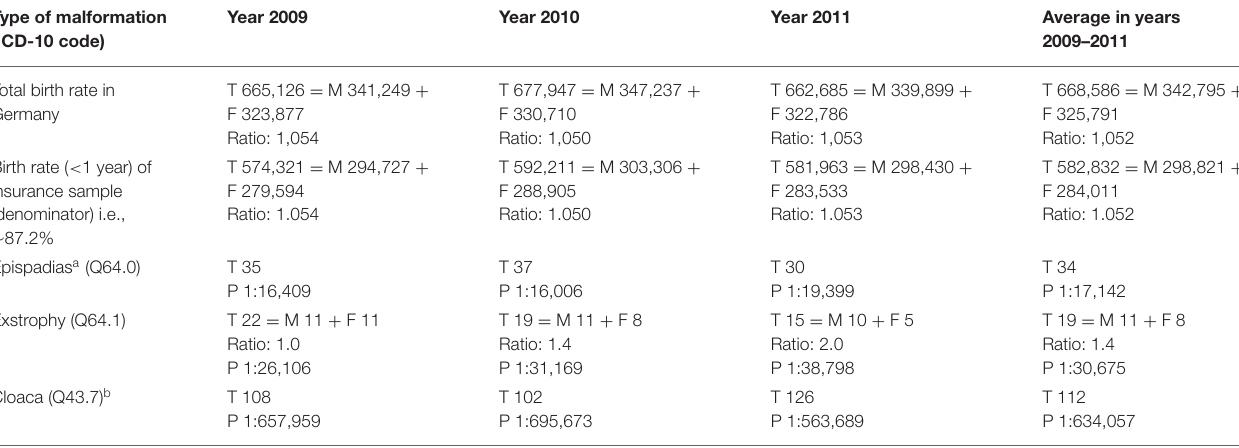
TABLE 4 | Outpatients below 1 year of age with EEC malformation for live prevalence estimation. Type of malformation (ICD-10